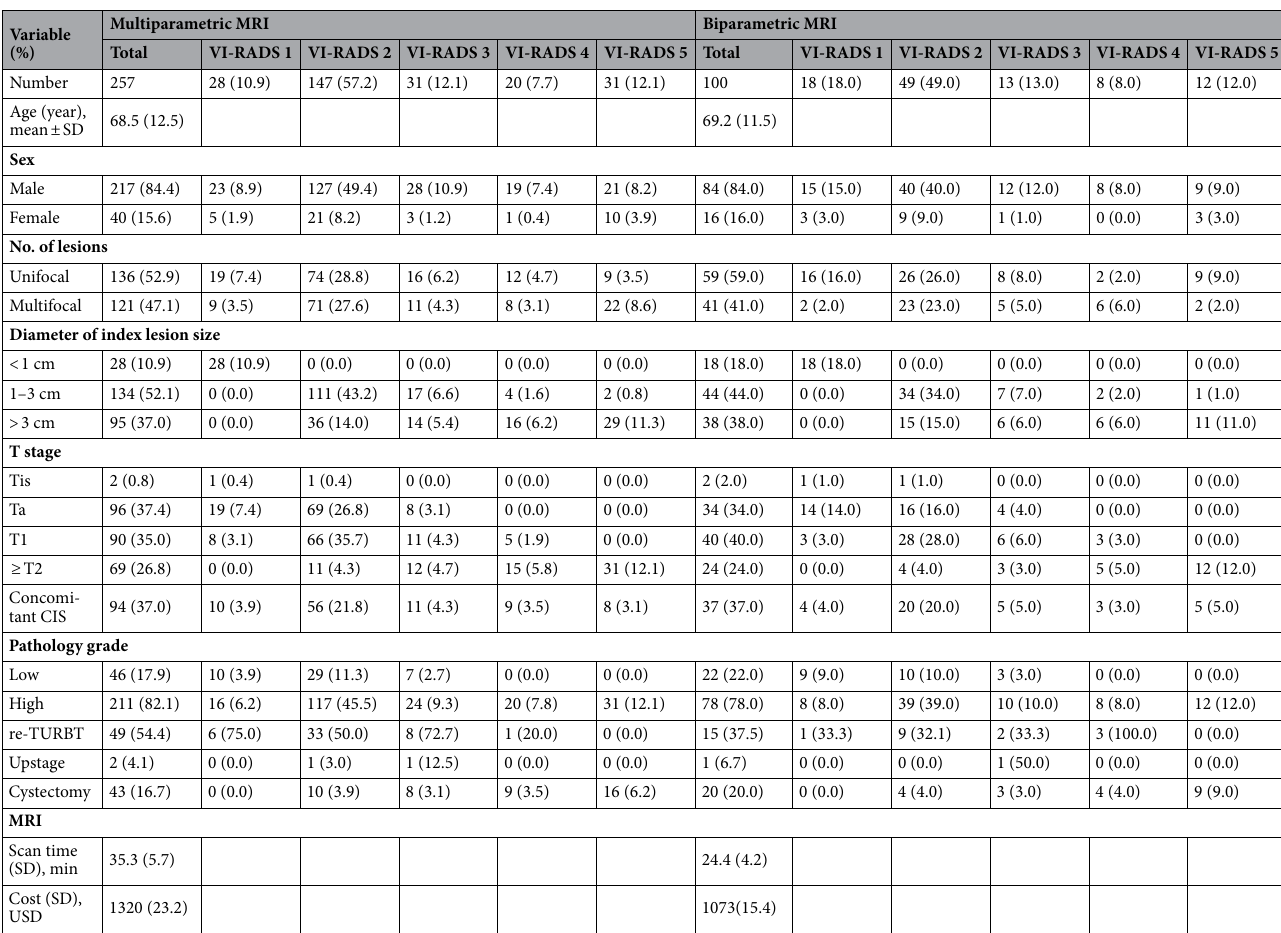
Table 1. Characteristics of patients with bladder cancer lesions using VI-RADS. Percentages are presented in parentheses. CIS carcinoma in situ, VI-RADS Vesical Imaging Reporting and Data System, re-TURBT repeated transurethral resection of a bladder tumor, Tis carcinoma in situ, Ta noninvasive papillary carcinoma, T1 tumor invades subepithelial connective tissue, T2 tumor invades muscular propria, MRI magnetic resonance imaging, SD standard deviation, USD United States